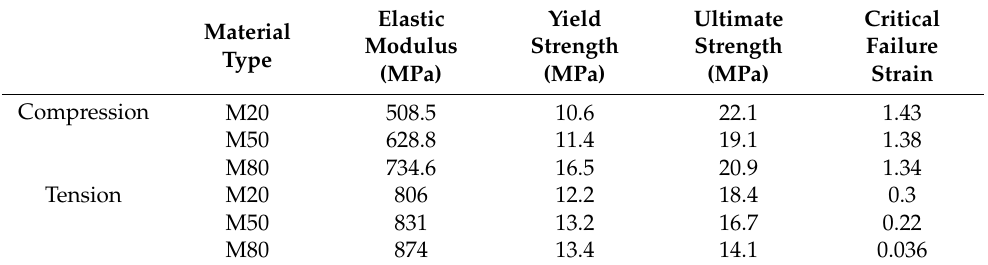
Table 2. Characteristic parameters of the Al-PTFE-W materials under quasi-static condition.